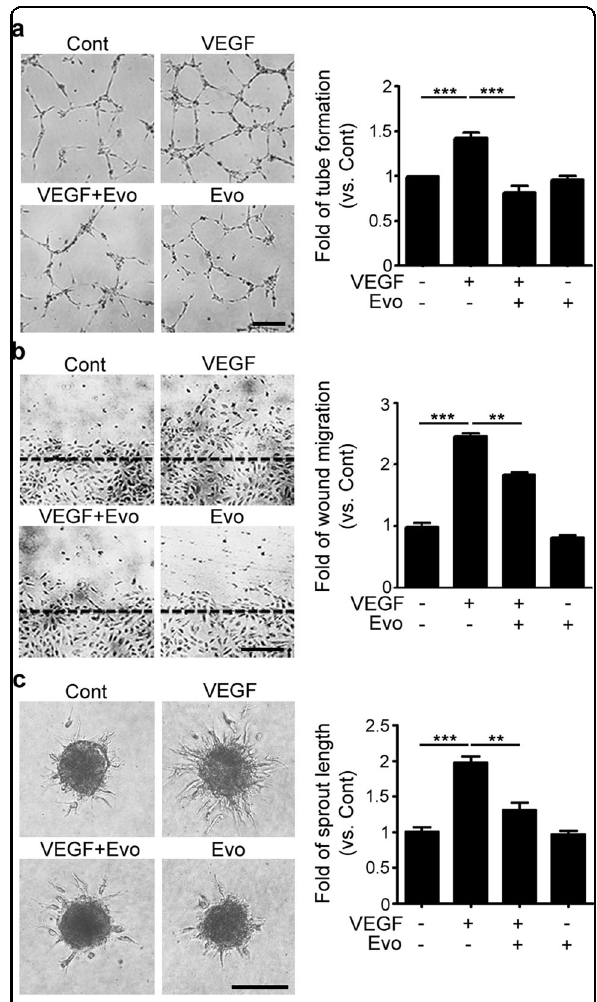
Fig. 2 Evogliptin suppressed VEGF-induced angiogenesis in endothelial cells. Evogliptin (Evo) blocked VEGF-induced increases in the a tube formation, b scratch wound migration, and c spheroid sprouting of HUVECs. Cells were treated with or without Evo (1 μ M) and VEGF (50 ng/mL). Tubular length, the relative area covered by migrating cells from the wound edges (black dashed lines), and the length of sprouts were measured and normalized to the values of the corresponding controls (Cont). Data are presented as the mean ± SEM (one-way ANOVA with Bonferroni post hoc multiple comparison test, ** p < 0.01, *** p < 0.001; n > 4 for tube formation assay, n = 3